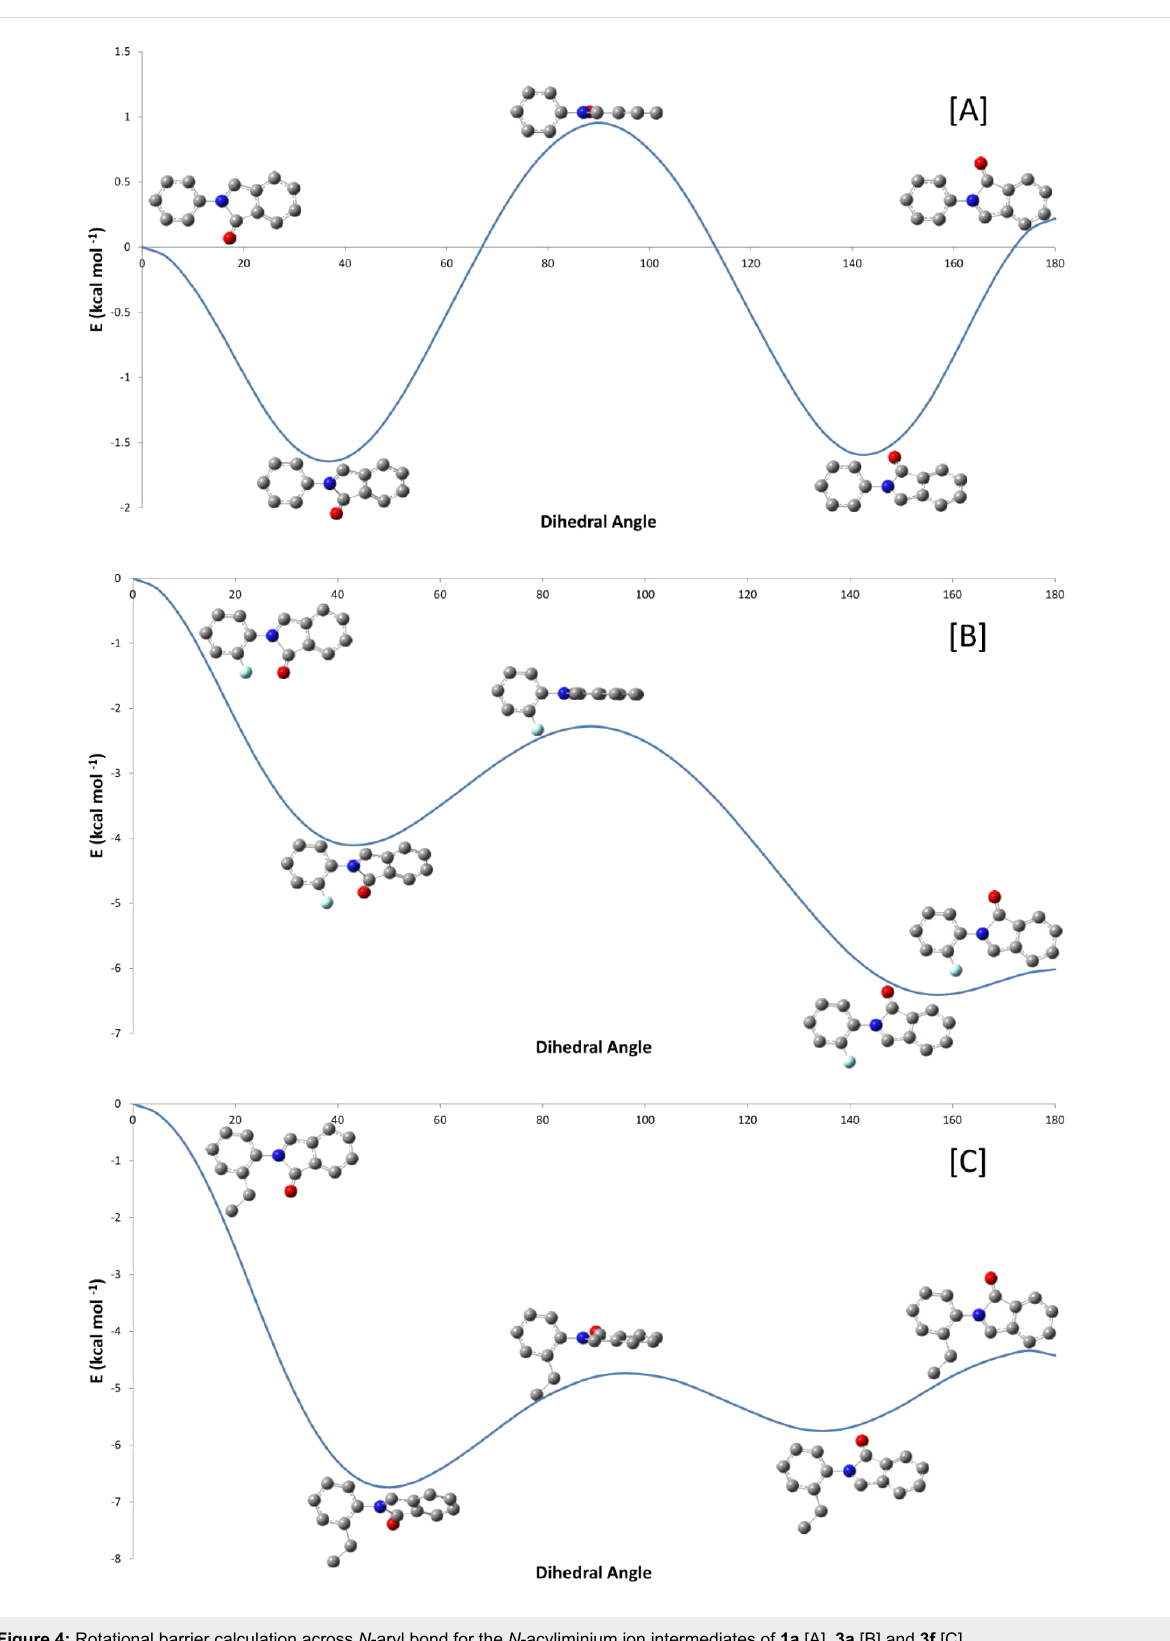
Figure 4: Rotational barrier calculation across N -aryl bond for the N -acyliminium ion intermediates of 1a [A], 3a [B] and 3f